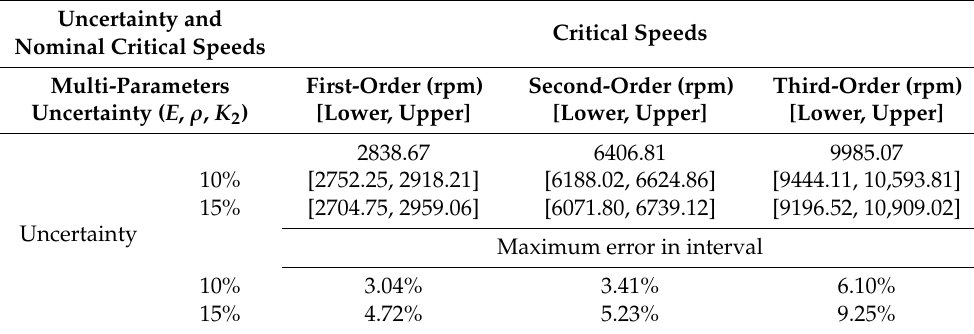
Table 6. Calculation of critical speeds under different